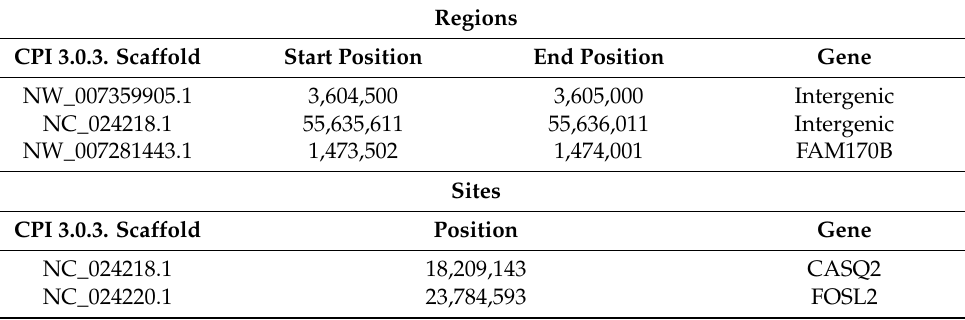
Table 2. Differentially methylated 500 bp regions and differentially methylated cytosines in the tail of Chrysemys picta selected for methylation-sensitive PCR. Intergenic regions are located outside any specific